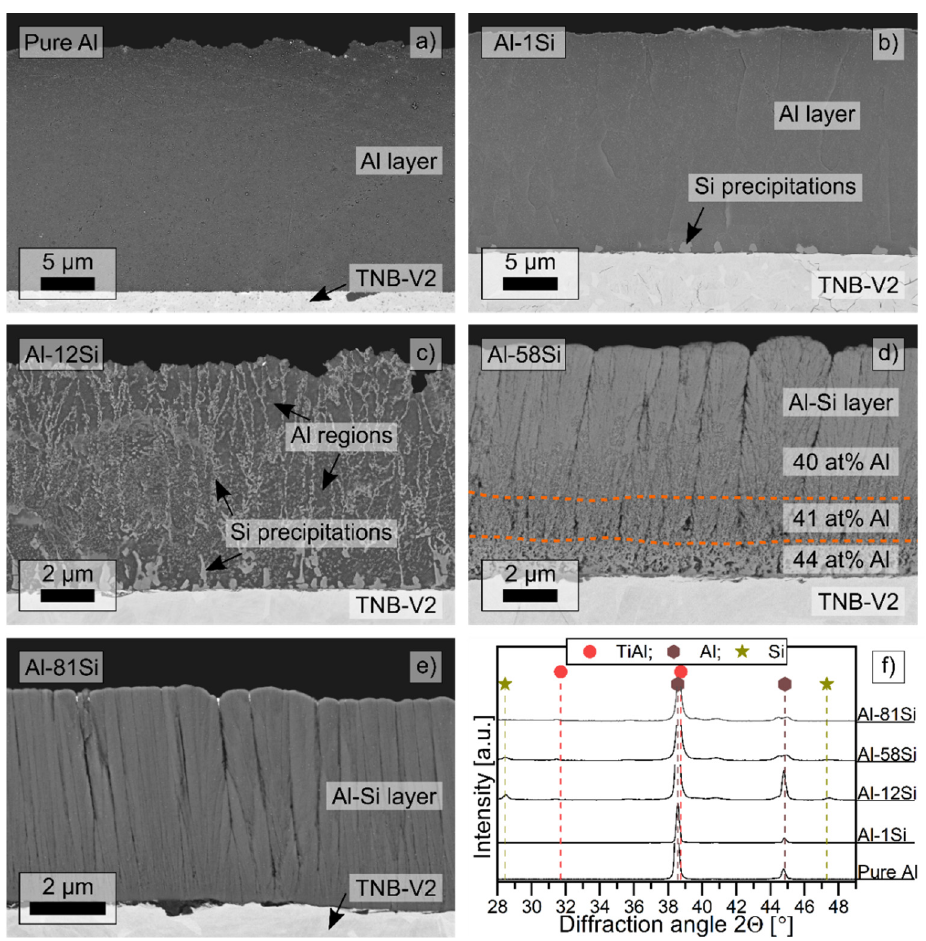
Figure 2. Cross sectional SEM images of the magnetron sputtered coatings on a TNB-V2 alloy: ( a ) the pure Al, ( b ) the Al-1Si, ( c ) the Al-12Si, ( d ) the Al-58Si with regions of different coating growth marked in orange and ( e ) the Al-81Si coating (all in at.%) in the as-deposited condition, as well as the corresponding X-ray diffractograms ( f ).